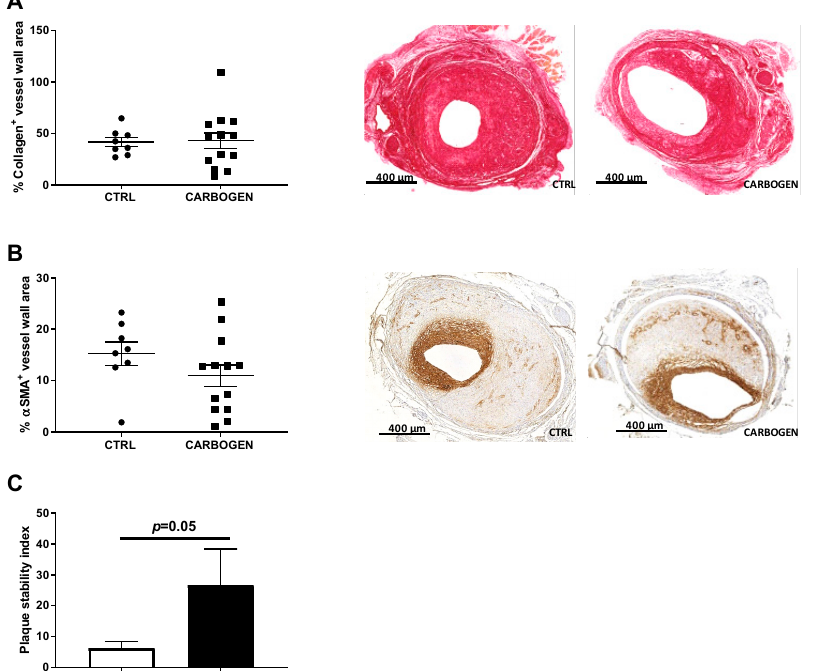
Figure 8. Chronic carbogen treatment does not affect collagen nor smooth muscle cells content in the lesion but increases plaque stability. ( A ) Quantitative measurement vessel wall area positive for collagen in ApoE3*Leiden mice from the control ( n = 8) and carbogen treated ( n = 13) groups. In the right panel representative pictures for collagen staining. ( B ) Quantification of percentage of vessel wall area positive for smooth muscle cell actin and representative pictures from the control ( n = 8) and carbogen treated ( n = 13) groups. ( C ) Quantification of plaque stability index. Data are presented as mean ± SEM.